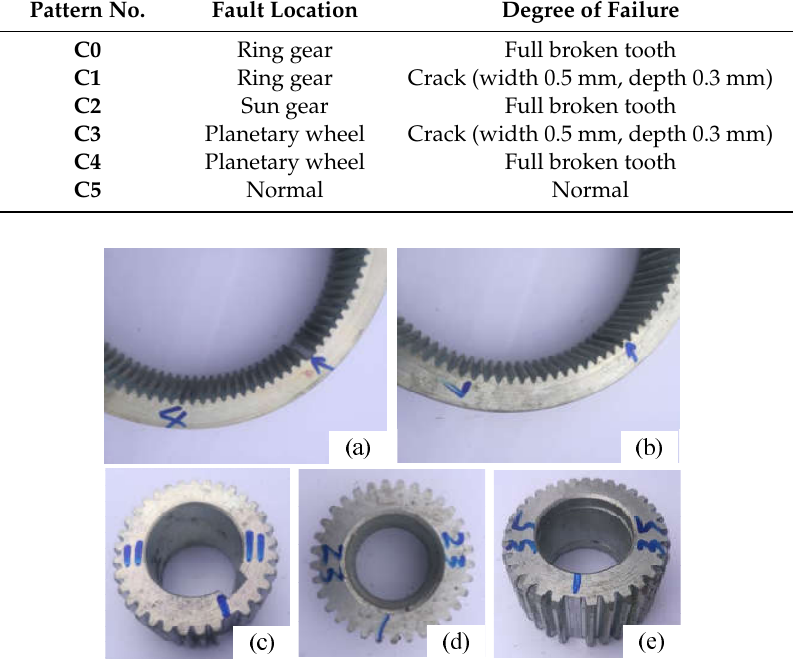
Figure 3. Five failure modes in the experiments: ( a ) ring gear with missing tooth; ( b ) ring gear with crack; ( c ) sun gear with missing tooth; ( d ) planetary gear root crack; ( e ) planetary gear with missing tooth.